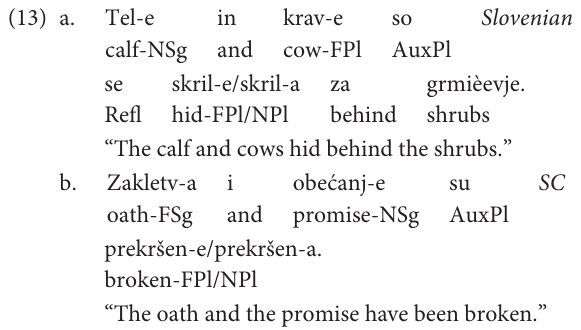
FIGURE 1 | The ratio between DEF, LCA, and FCA for all plural conjuncts.